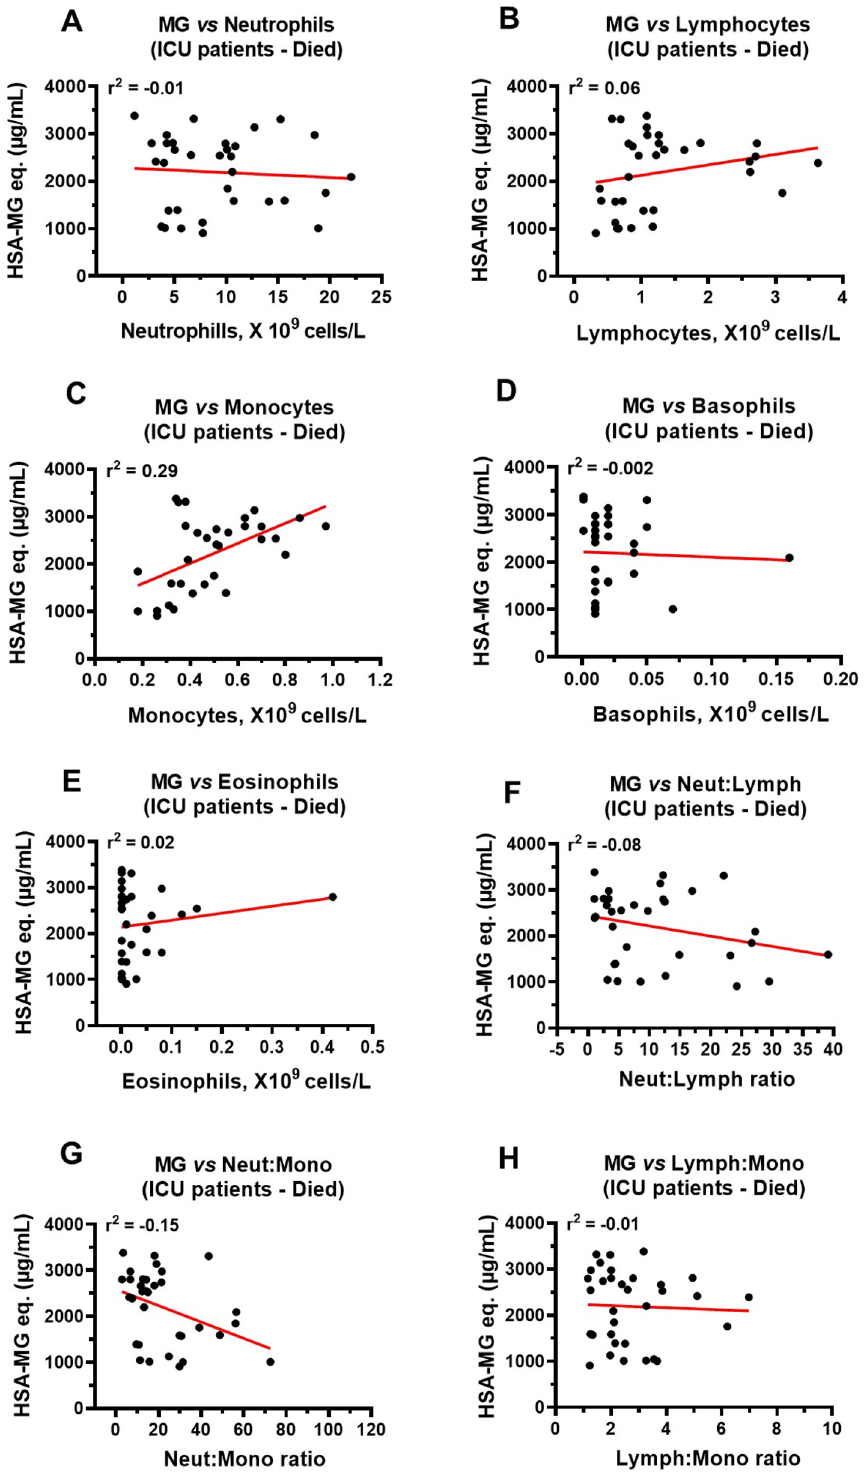
Figure 11. Correlations between plasma MG and neutrophils, lymphocytes, monocytes, basophils, and eosinophils in ICU patients that died. ( A , B ) No significant correlations between MG and neutrophils (r 2 = − 0.01) and lymphocytes (r 2 = 0.06) in ICU patients that died. ( C ) A significant correlation between plasma MG and monocytes (r 2 = 0.29) in ICU COVID-19 patients that died. ( D – H ) No significant correlations between MG and basophils (r 2 = − 0.002), eosinophils (r 2 = 0.02), neutrophil:lymphocyte ratio (r 2 = − 0.08) neutrophil:monocyte ratio (r 2 = − 0.15) and lymphocytes:monocytes ratio (r 2 = − 0.01), respectively in ICU COVID-19 patients that died. Data in graphs are for n = 33